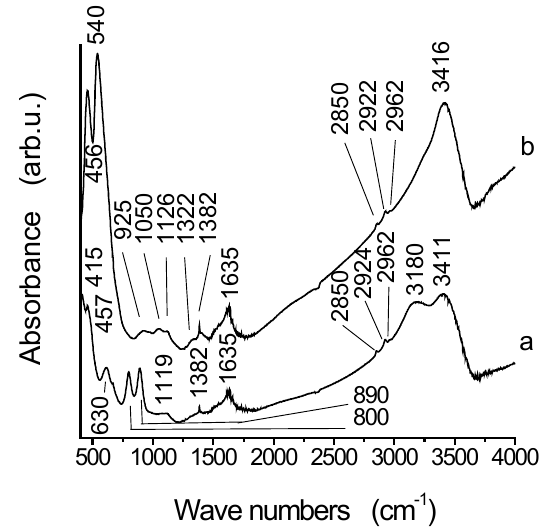
Figure 4. Mid-IR spectra from KBr pellet of the initial biomass sample (a) and after its treatment in Ar flow at 250° С (b).